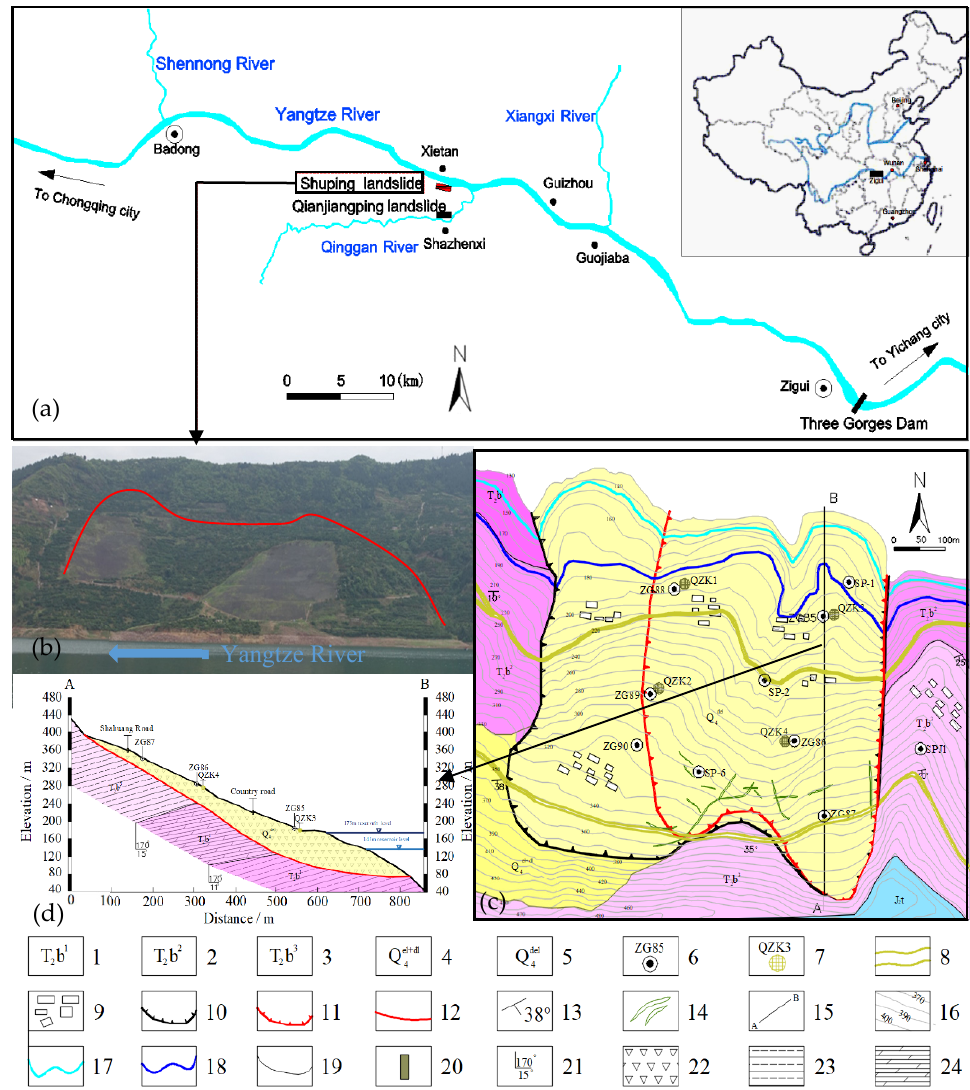
Figure 2. Basic information of Shuping landslide. ( a ) Location of the Shuping landslide, modified from [31]. ( b ) Photo of the Shuping landslide. ( c ) Topographic map of the Shuping landslide displayed at the monitoring stations. ( d ) Geologic profile of section A–B. Note: 1, Siltstone mixed with mudstone and shale in T2b1; 2, Limestone and marble in T2b2; 3, Mudstone and siltstone in T2b3; 4, Quaternary residual slope deposits; 5, Quaternary landslide deposits; 6, Ground surface GPS monitoring stations and numbers; 7, Deep inclinometer hole and its number; 8, Road; 9, Buildings; 10, Landslide boundary; 11, Landslide boundary of main sliding area; 12, Sliding belt; 13, Rock occurrence; 14, Long ground fissures; 15, Sectional line; 16, Contour elevation; 17, The lowest RWL line; 18, the highest RWL line; 19, Stratum boundary; 20, Road in section; 21, Formation occurrence; 22, Quaternary landslide deposits; 23, Silty mudstone; 24, Argillaceous limestone.